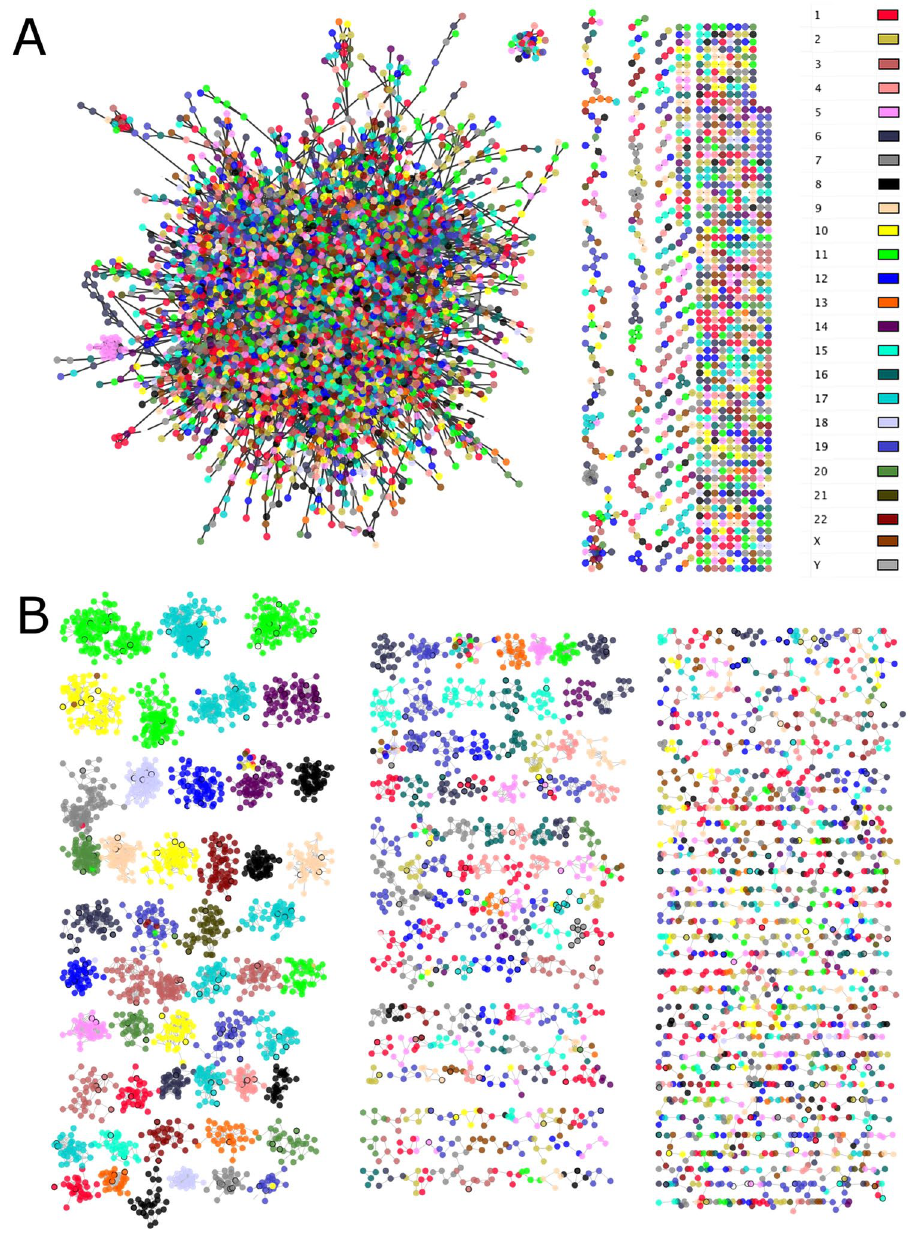
Figure 2. Inter-chromosomal regulation loss in cancerous network. ( A ) Healthy network (HN). ( B ) Cancerous network (CN). This figure shows the architectural features of each network. Both networks are depicted with the same layout as in Fig. 1. The color code is according to the chromosome location in which each gene is placed. Notice the presence of a single giant component in the HN, which is not the case for CN, where several small components coexist. Furthermore, in the HN of panel (A) all genes in the giant component belong to different chromosomes, meanwhile in the CN of panel (B), almost all components are composed of genes which belong to the same